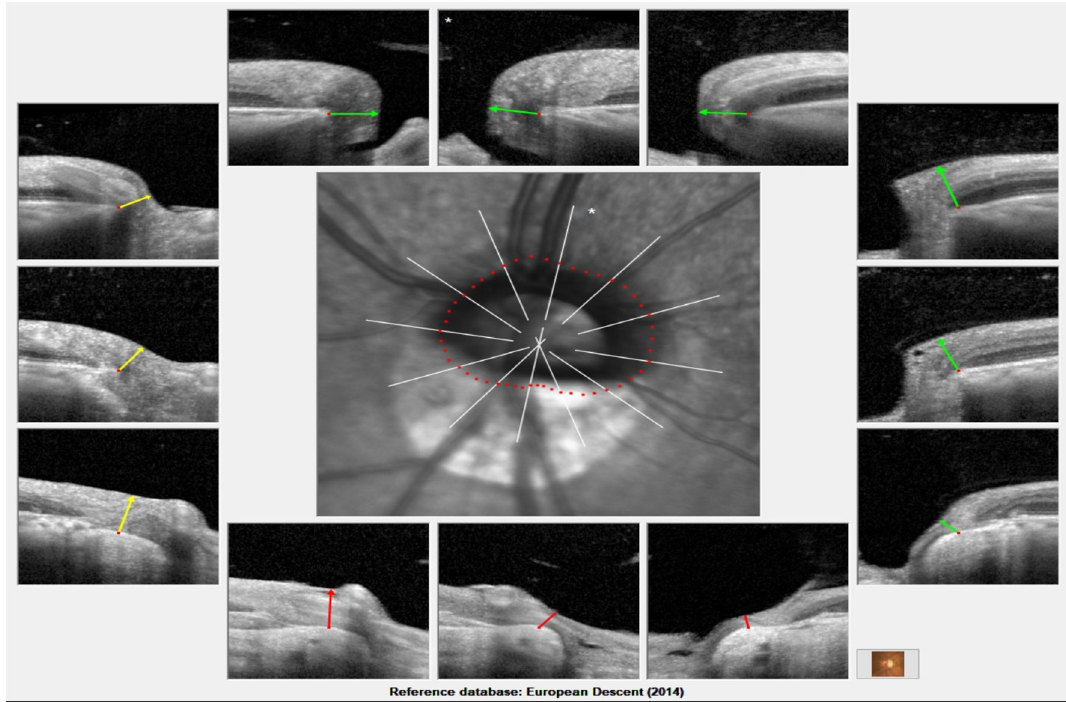
Figure 4. Bruch’s membrane opening-minimum rim width (BMO-MRW) measurement in a high myopic patient. Green, yellow, and red lines represent the least distance between Bruch’s membrane opening and the internal limiting membrane. Green, yellow, and red color of the lines represent the classification of BMO-MRW measurement within normal limits, borderline and out of normal limits, respectively. Table 3. Characteristics of RNFL measurement in highly myopic